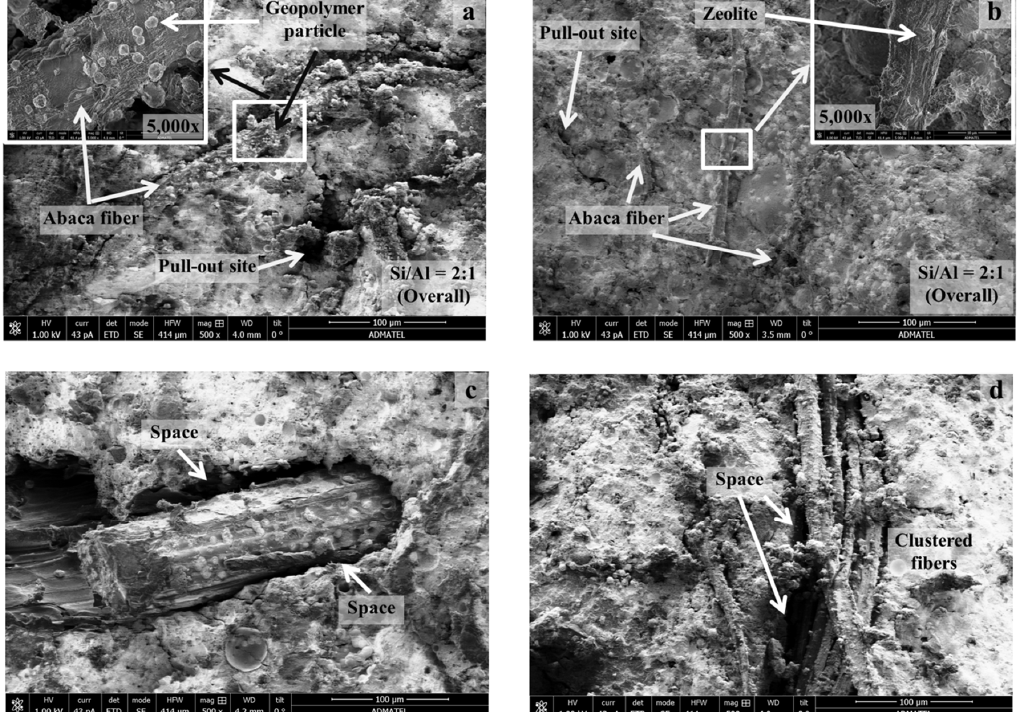
Figure 13. SEM images of composite fractured surfaces: ( a ) reinforced with untreated abaca; ( b ) reinforced with treated abaca; ( c ) interface between untreated abaca fiber and geopolymer matrix and ( d ) interface between treated abaca fiber and geopolymer matrix.